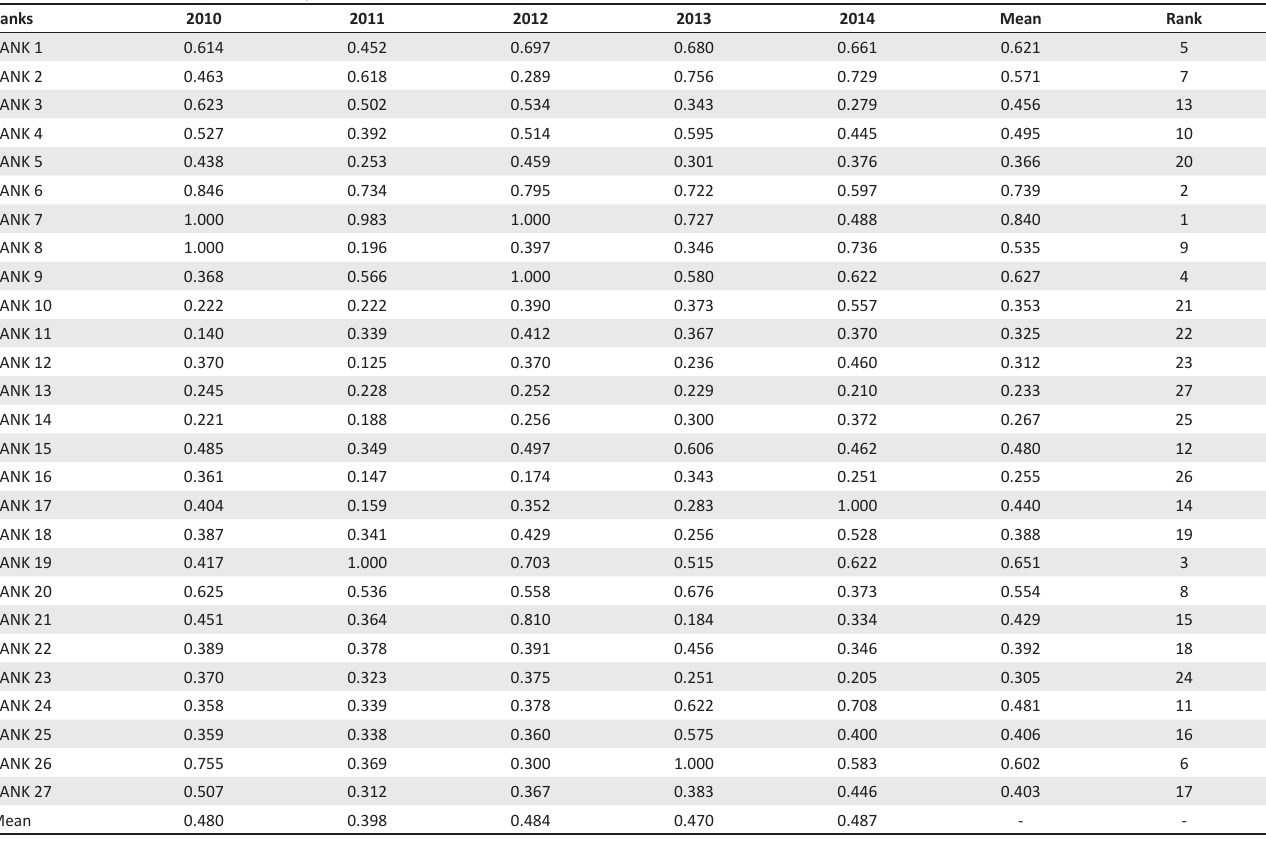
TABLE 2: The slack-based overall efficiency of banks in Ghana.